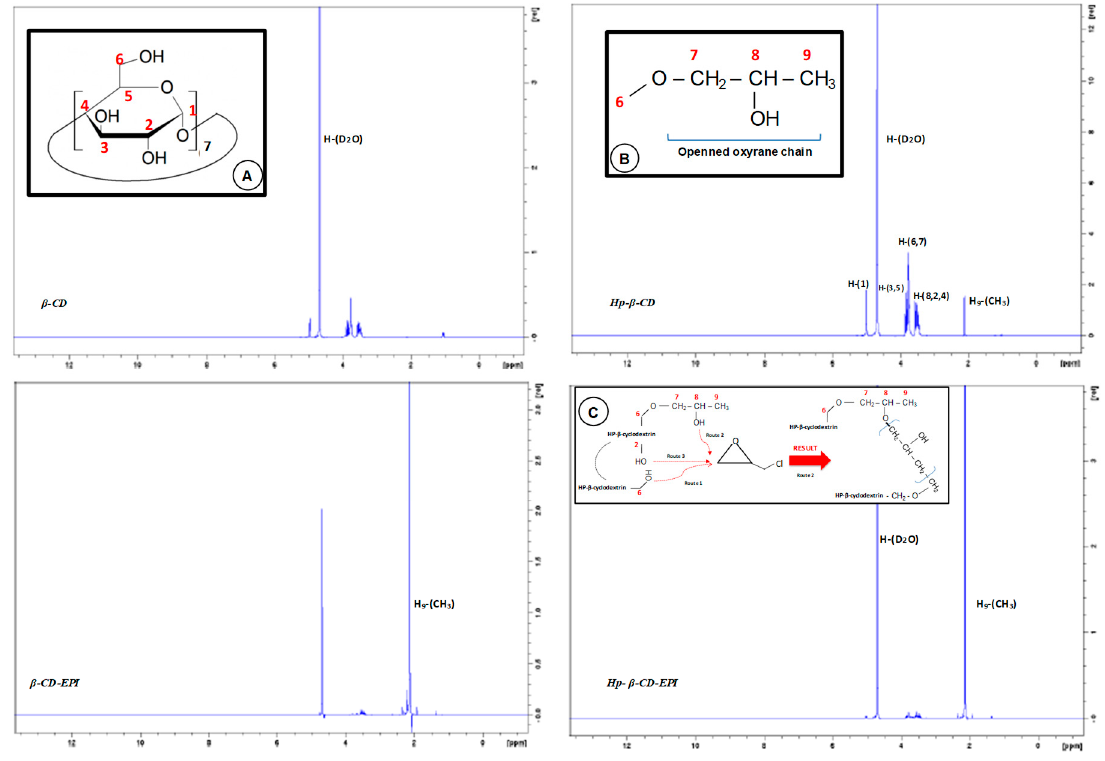
Figure 7. 1 H-NMR spectra of β -CD, HP- β CD, β - and HP- β -CD EPI polymers. Inset: A: β -CD monomer glucose unit chemical structure; B: HP- β -CD spacer arm; C: Possible ways to open oxyrane ring by OH groups.